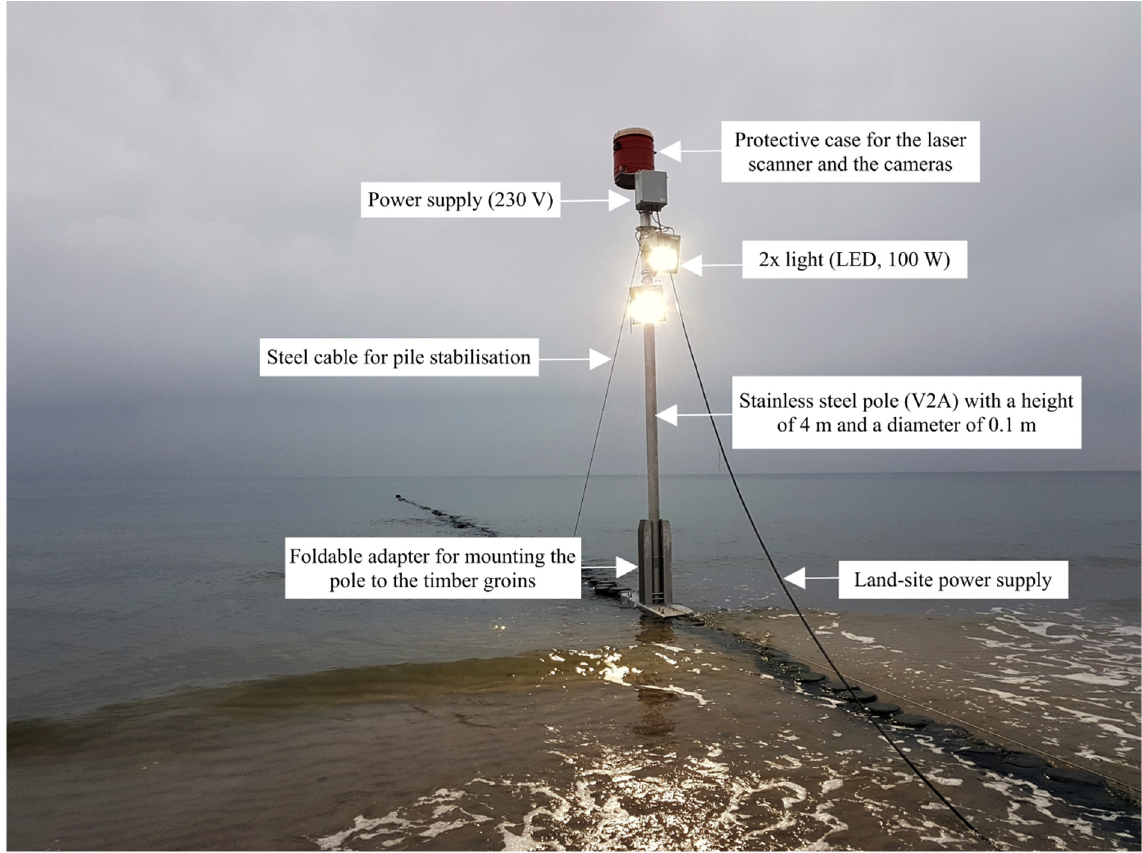
Figure 9. Survey equipment incl. laser scanner, cameras, and light mounted on a timber groin (Photo: Christian Kaehler).